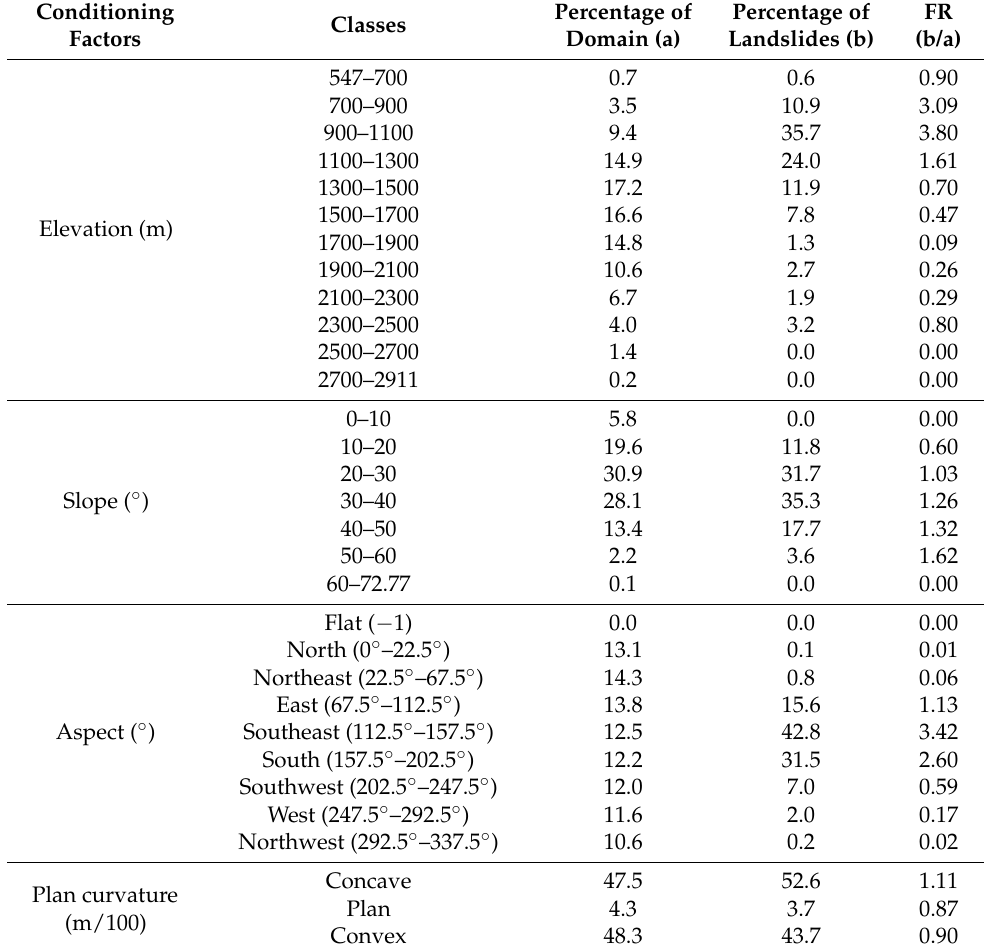
Table 2. Correlation between landslides and conditioning factors using frequency ratio (FR)